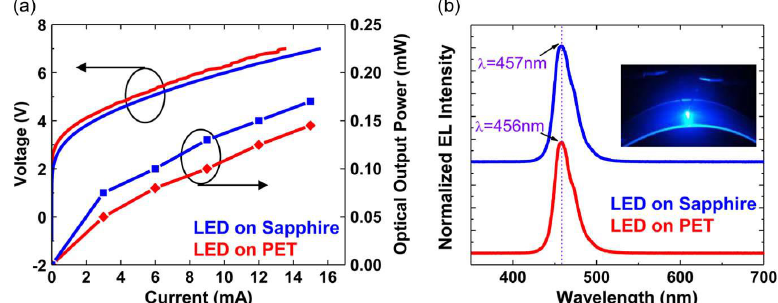
Figure 9. ( a ) Light output power-current-voltage (L-I-V) characteristics and ( b ) electroluminescent light spectra of the GaN LEDs on sapphire substrate (before laser lift-off) and PET substrates (after transfer-printing). The insert in Figure 9b shows the light emission images on a PET substrate (reprinted from [44]).